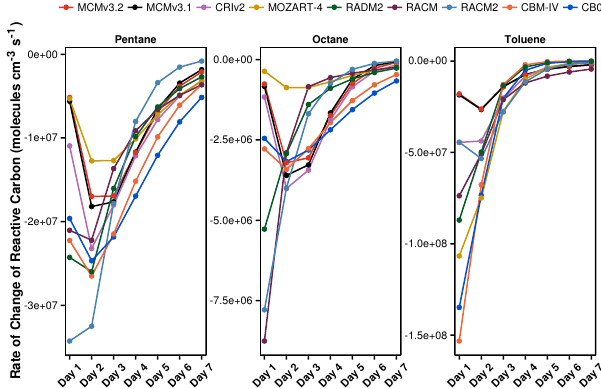
Figure 8. Daily rate of change in reactive carbon during pentane, octane and toluene degradation. Octane is represented by the five carbon species, BIGALK, in